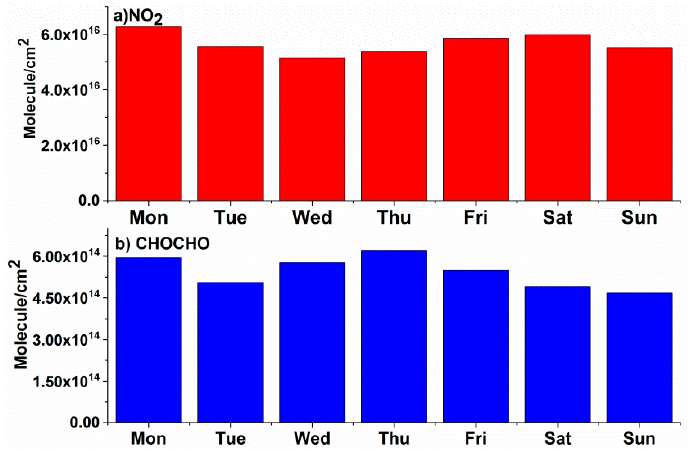
Figure 8. Weekly cycles for ( a ) NO 2 and ( b ) CHOCHO VCDs monitored in Hefei, China.